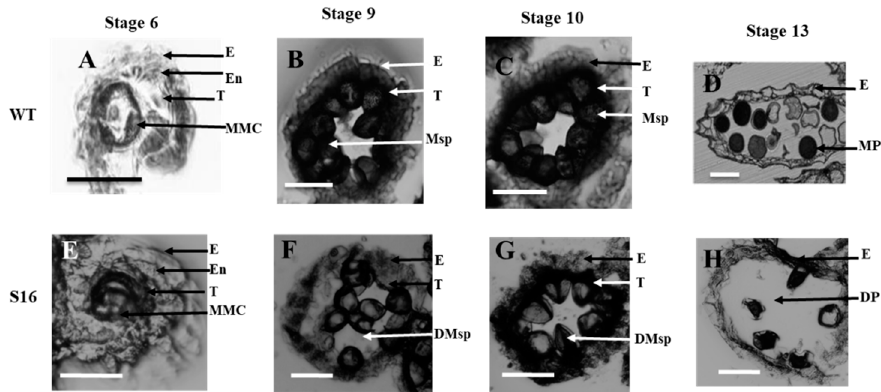
Figure 6. Transverse section analysis of the anther development in WT and osros1a S16 mutant. Locules from the anther section of WT and S16 at ( A , E ) stage 6 (the microspore mother cells stage), ( B , F ) stage 9 (the young microspore stage), ( C , G ) stage 10 (the vacuolated pollen stage), and ( D , H ) stage 13 (the mature pollen stage). WT sections are shown in ( A – D ); osros1a S16 mutant in ( E – H ). E, epidermis; T, tapetum; En, endothecium; MMC, microspore mother cells; Msp, microspores; MP, mature pollen; DMsp, degenerated microspores; DP, the degenerated pollen. Scale bar: 50 µ